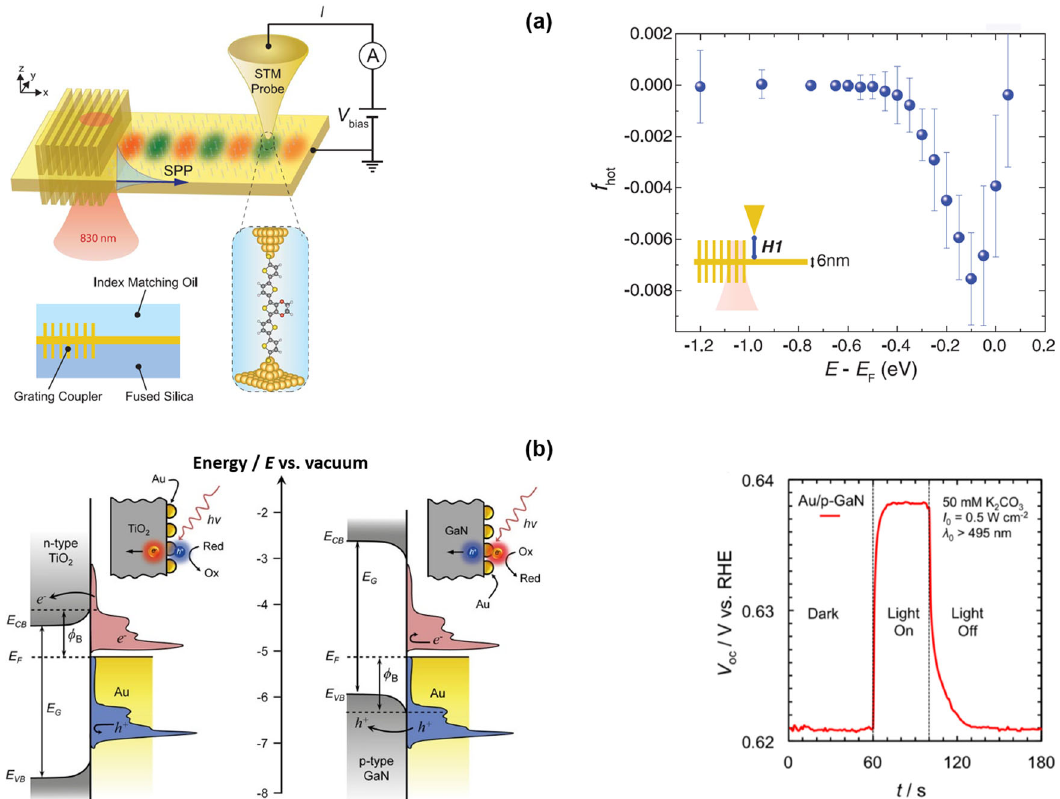
Fig. 4 Demonstration of energy distribution and charge separation across interfaces. a Schematic of the experimental setup to determine charge-carrier energy distribution by forcing the electrical current through the suitably chosen molecular level and measured hot-hole energy distribution in a 6-nm-thick Au fi lm. (from ref. 33 reprinted with permission from AAAS). b Energetically tailored Au/p-GaN interface to localize hot holes to p-GaN (Au/TiO 2 system demonstrate that holes cannot cross the interface) and a positive shift in open-circuit voltage (V oc ) of Au/p-GaN under visible light irradiation (reprinted with permission from ref. 34 copyright © 2018, American Chemical